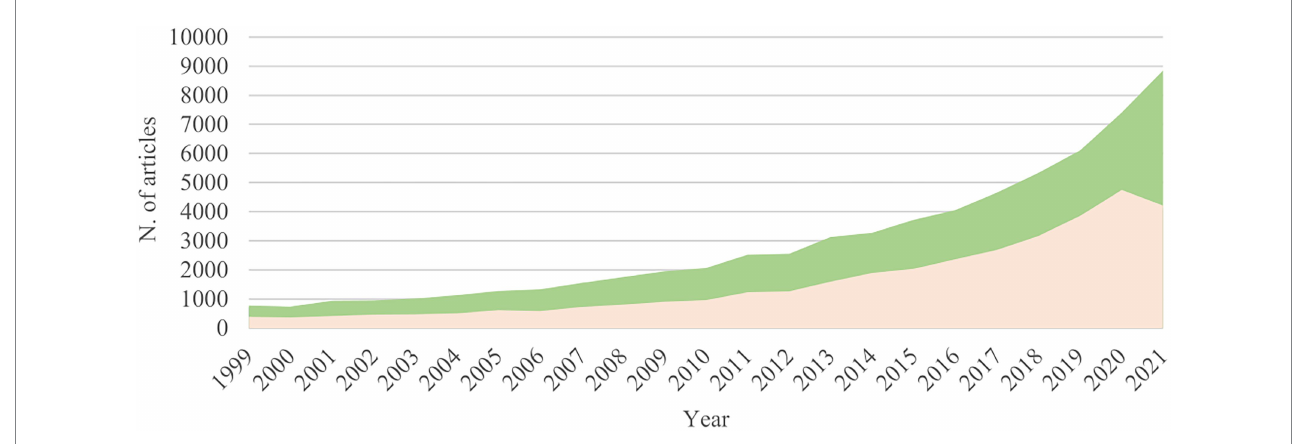
FIGURE 1 Evolution of the field of co-culture; Number of publications per year in the fields of co-culturing microorganisms to increase biological activity (green), and co-culturing microorganisms to enhance chemodiversity and induce the production of novel secondary metabolites (salmon). These numbers were obtained by a metric search from 1999 to 2021 (Web of Science/Science